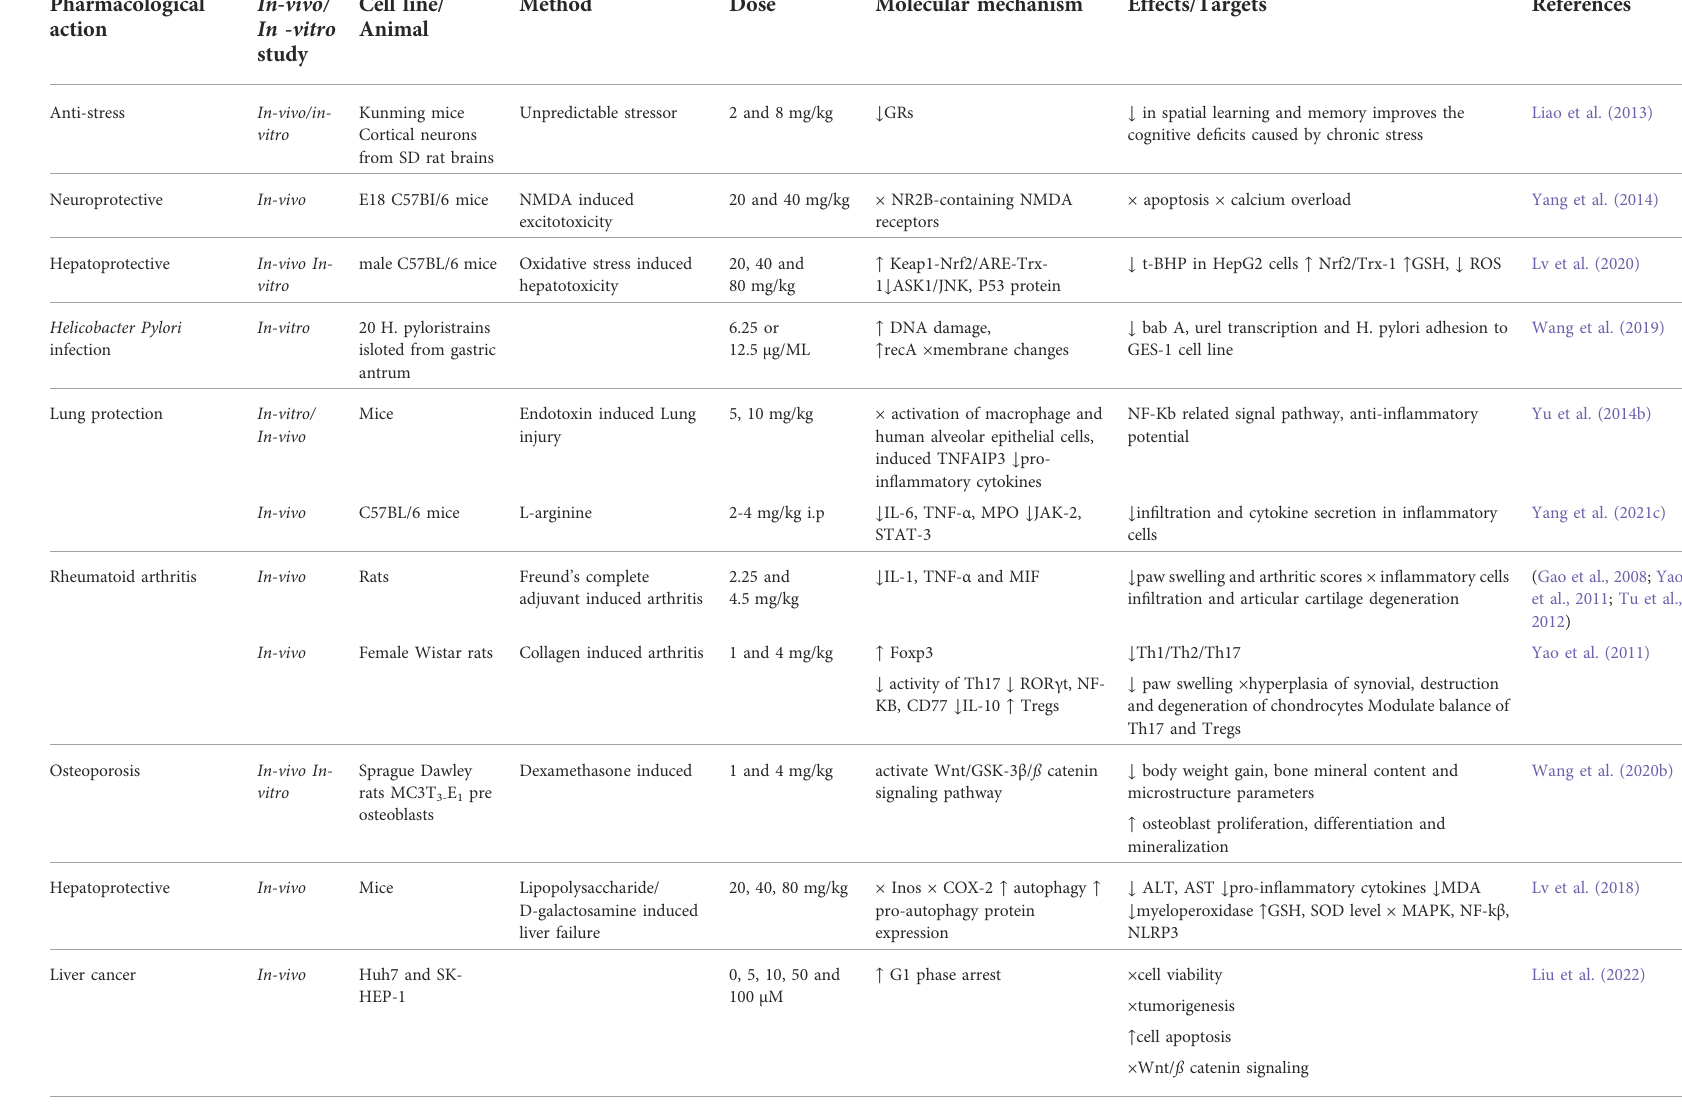
TABLE 1 Pharmacological activities of